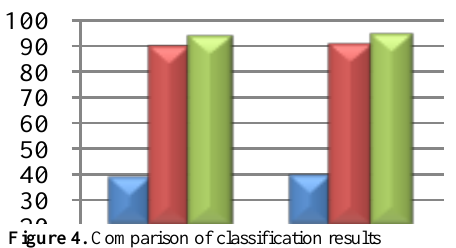
Figure 5. Comparison of class accuracies between different classification strategies The reasonable cause of these results is that Tree and Building are 3D class that height information of LIDAR data could highlight them in classification. In the same time, LIDAR independently could not detect Grass classes, soil and water because these classes need spectral information. Finally, figure 6 demonstrates the classification map of classifier fusion